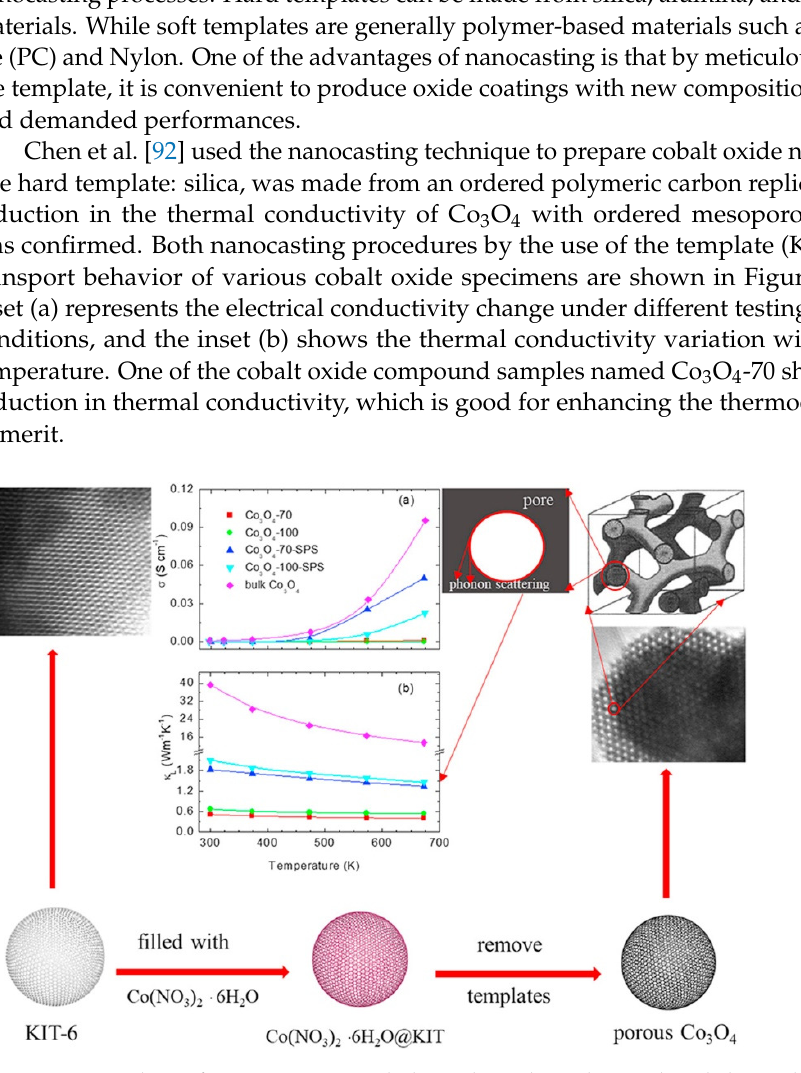
Figure 7. Procedures for nanocasting cobalt oxide and its electrical and thermal conductivities: ( a ) electrical conductivity, and ( b ) thermal conductivity. Reproduced with permission from [92], © 2019, Elsevier Inc.